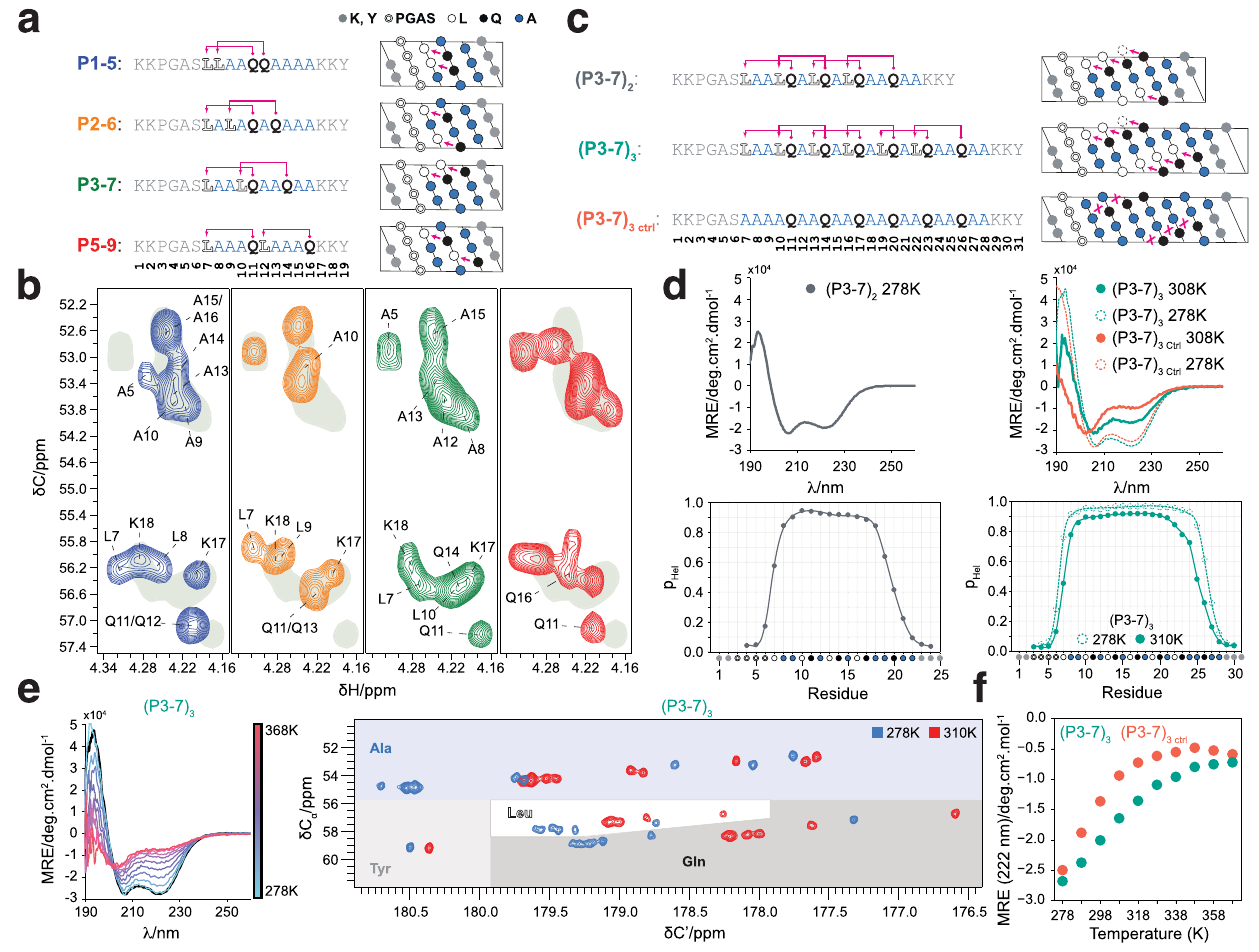
Fig. 1 | Design of single α -helices stabilized by Gln side chain to main chain hydrogen bonds. a Sequences and representation as helical projections of the peptidesusedtoinvestigatecooperativity,wherepinkarrowsindicateputativeGln side chain to main chain interactions. b Selected region of the 2D 1 H 13 ,C HSQC spectra of the peptides at 278K, where the shaded area corresponds to that of peptide P3-7, which has the highest helical propensity. c Sequence and repre- sentation as helical projections of peptides (P3-7) 2 and (P3-7) 3 , as in a . d Top: CD spectra of peptides (P3-7) 2 , (P3-7) 3 , and (P3-7) 3 Ctrl at the indicated temperatures.